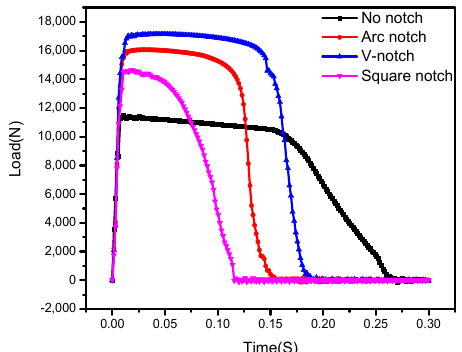
Figure 5. Bolt models of four structures. ( a ) Non-notch; ( b ) arc-shaped; ( c ) V-shaped; ( d ) square notch.